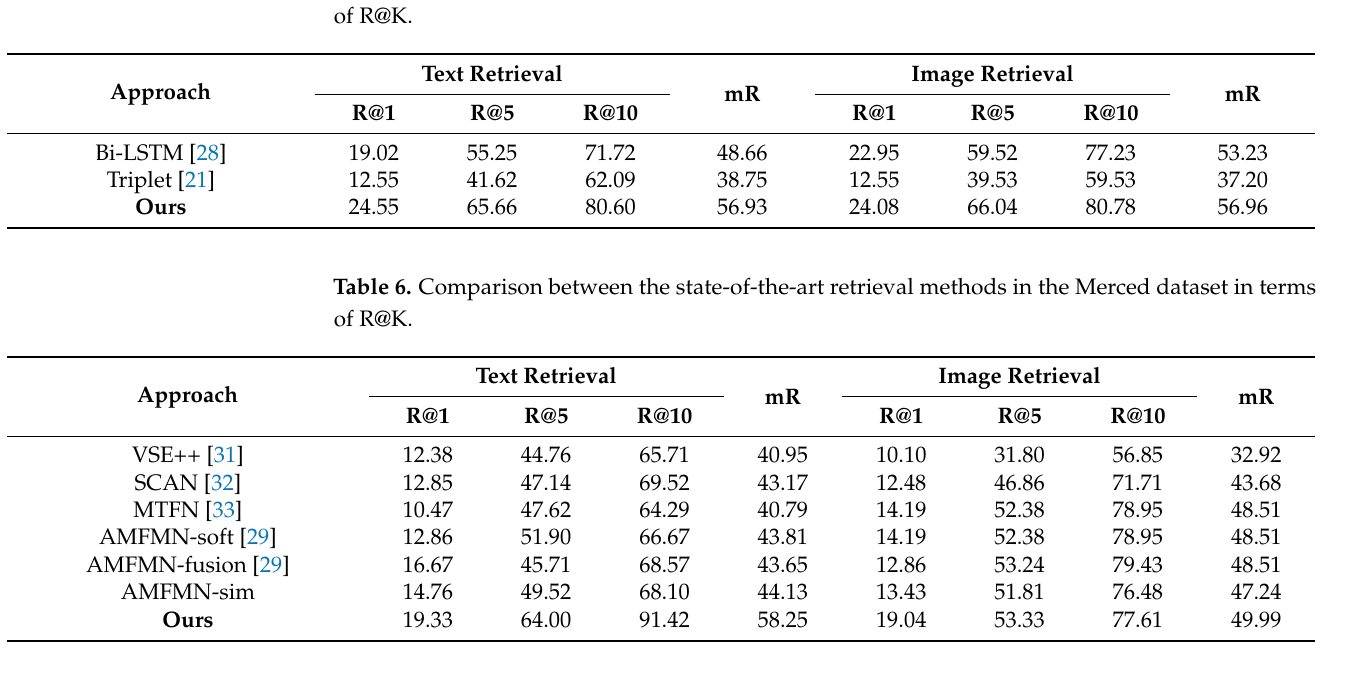
Table 7. Comparison between the state-of-the-art retrieval methods in the Sydney dataset in terms of